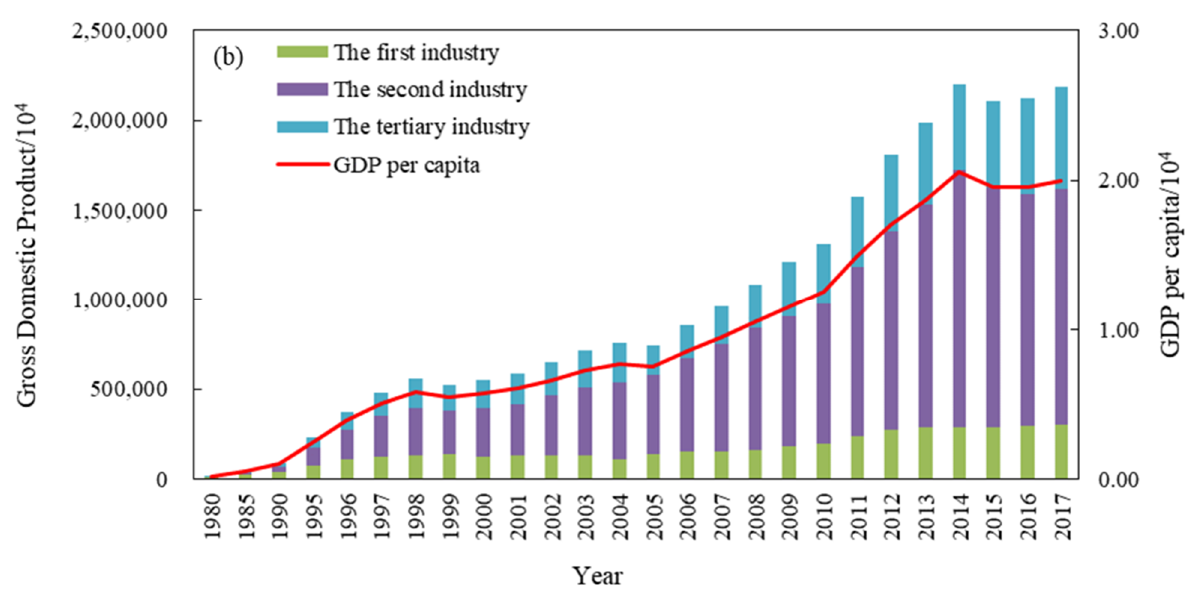
Figure 12. Changes in the economic and social factors in the Xiong’an New Area from 1980 to 2017. ( a ) Population and ( b ) economy. The data source: Baoding City Economic Statistics Yearbook (https://data.cnki.net/area/Yearbook/Single/N2017120334?z=D03 (accessed on 20 November 2020)).